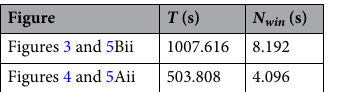
Table 4. Hyper-parameters for the estimation of information.